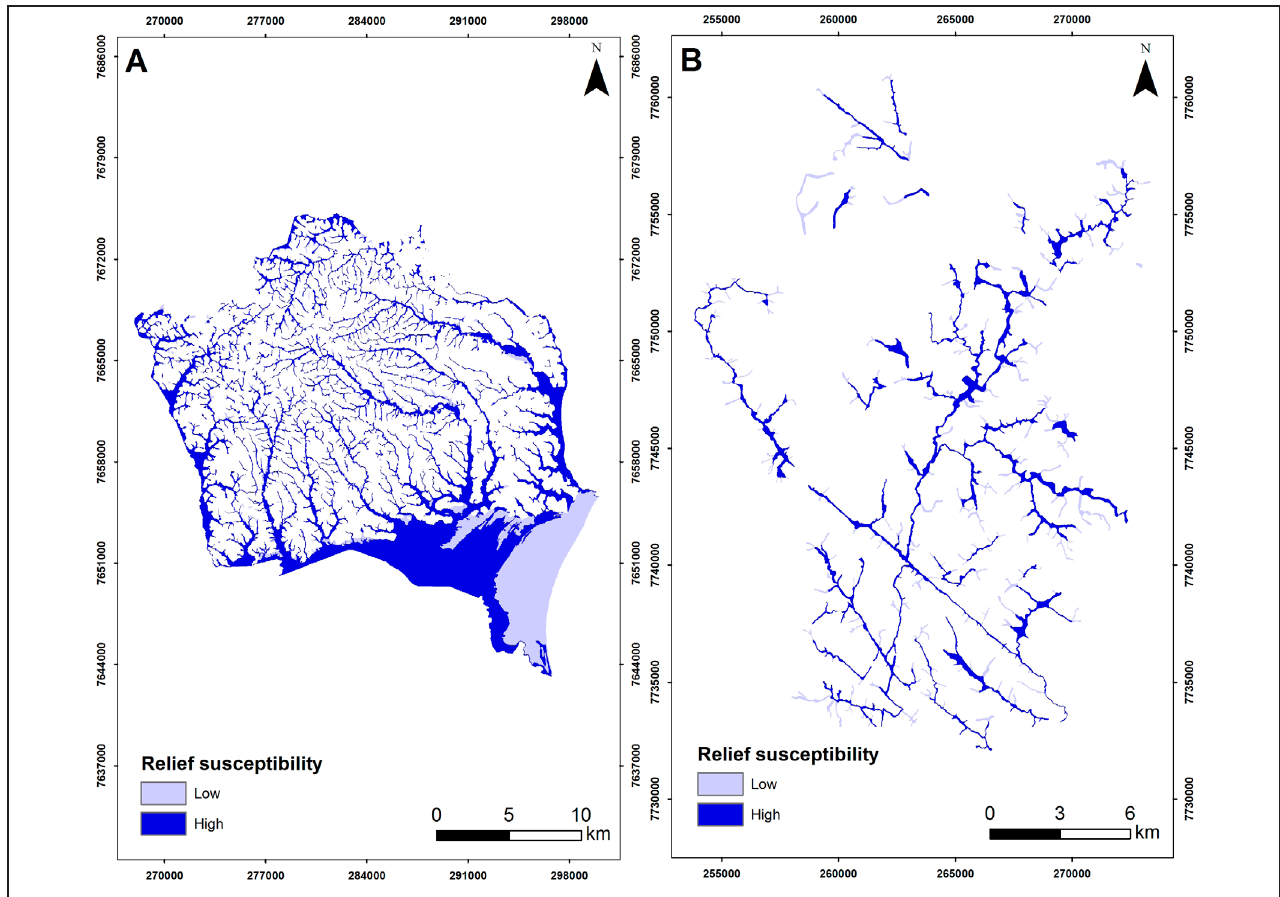
Figure 5 - Raster susceptibility classification of relief patterns regarding the flooding process.